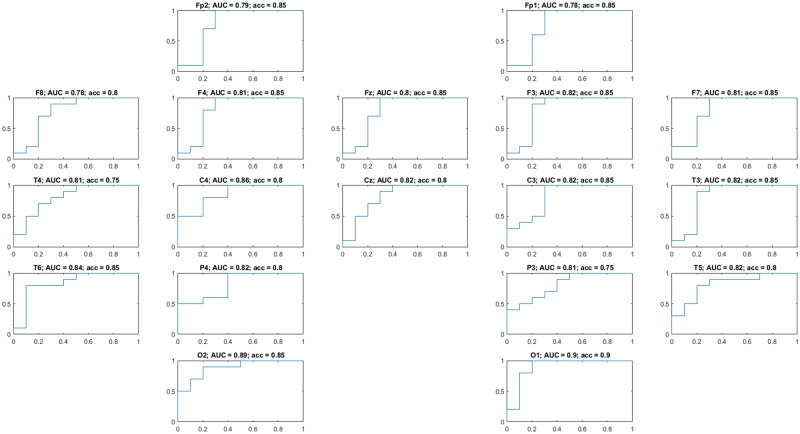
Results of the ROC analysis for all channels.The best channels are O1 and O2 since we want to minimize the false positive rate while having a good true positive rate.